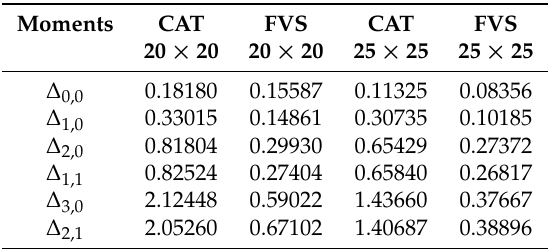
Table 4. Quantitative weighted sectional errors for sum